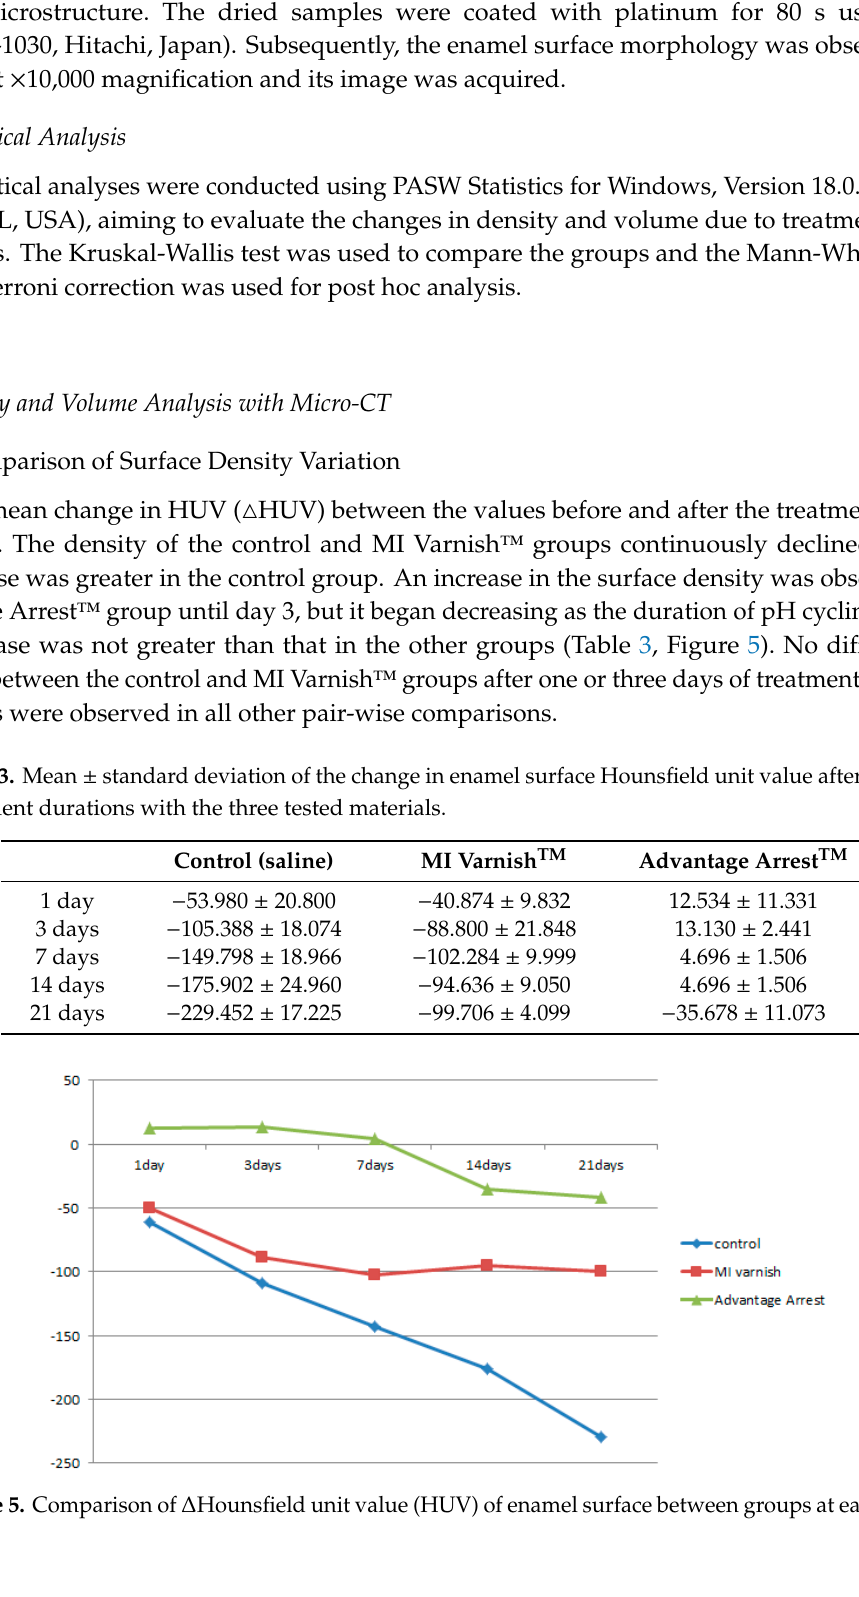
− 41.342 ± 3.155 Figure 6. Comparison of the change in mean enamel Hounsfield unit value at a depth of 0–20 μ m between groups at each time point.